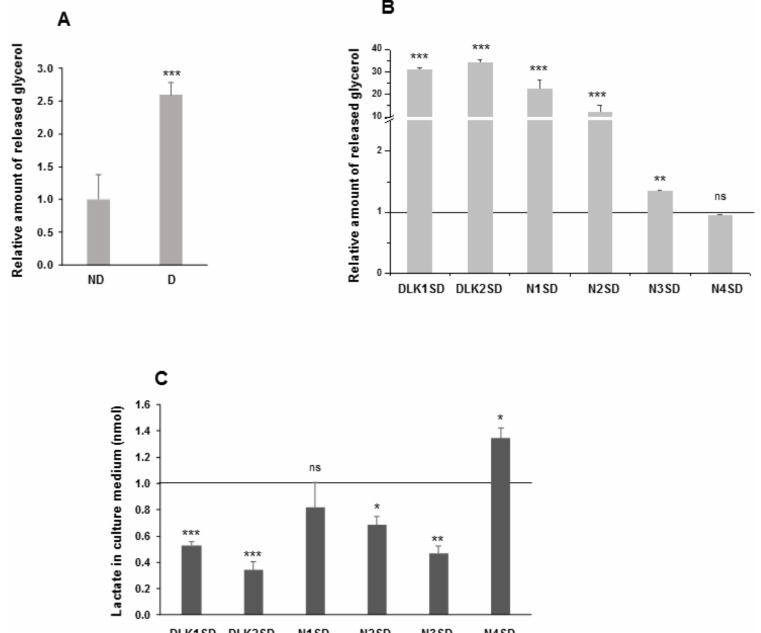
Figure 6. Lipolytic potential and release of lactate to the extracellular medium in C3H10T1 / 2 adipocytes overexpressing Dlk or Notch genes. ( A ) Relative levels of glycerol released to the extracellular medium in response to isoproterenol from non-differentiated (ND) and differentiated (D) C3H10T1 / 2 cells. ( B ) Relative levels of glycerol released to the extracellular medium in response to isoproterenol from differentiated Dlk- or Notch- overexpressing cells. ( C ) Relative levels of lactate released into the culture media of differentiated Dlk- or Notch- overexpressing C3H10T1 / 2 cells. The fold activation or inhibition levels were calculated relative to the levels of non-differentiated cells ( A ) or empty-vector-differentiated cells ( B , C ), which were set arbitrarily at 1 (horizontal black line or ND cells). Data are shown as the mean ± SD of at least three biological assays performedintriplicate. ThestatisticalsignificancecalculatedbyStudent’s t -testisindicated(* p ≤ 0.05,** p ≤ 0.01, *** p ≤ 0.001). Non-statistical significance is indicated by ns.